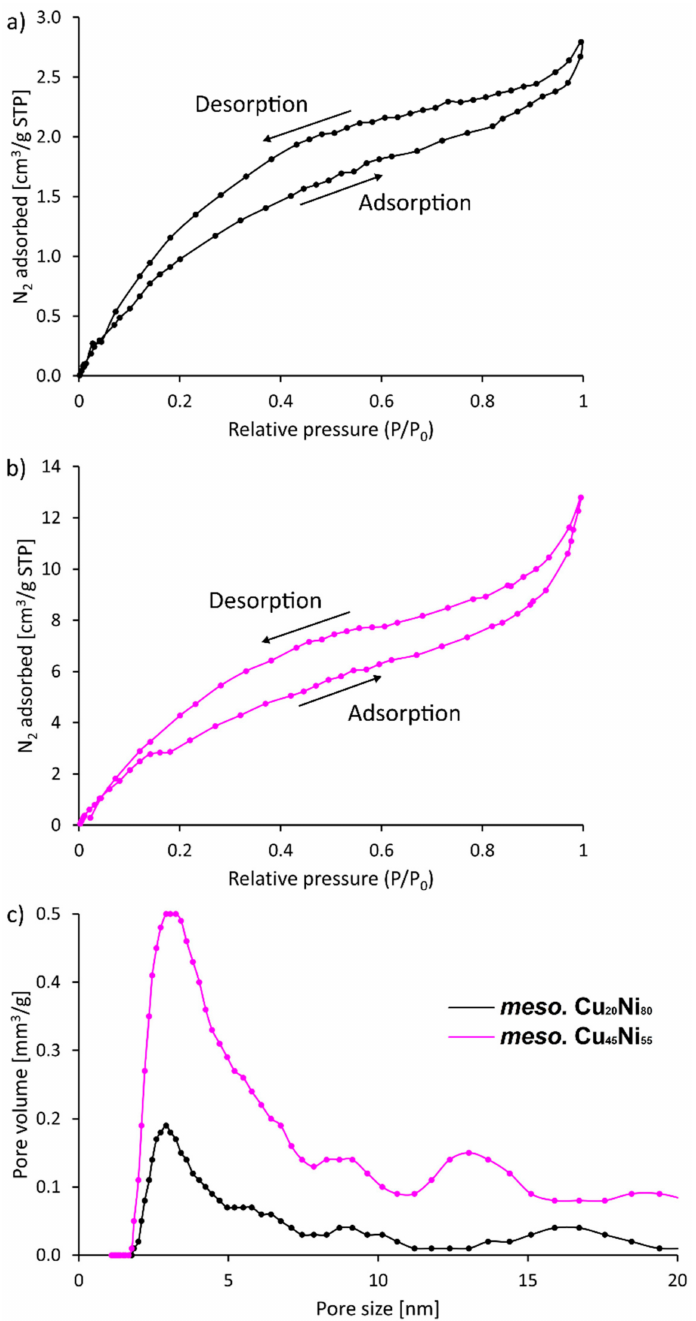
Figure 6. N 2 isotherms for ( a ) Cu 20 Ni 80 and ( b ) Cu 45 Ni 55 surface-mesostructured films; ( c ) resulting pore size distribution for both